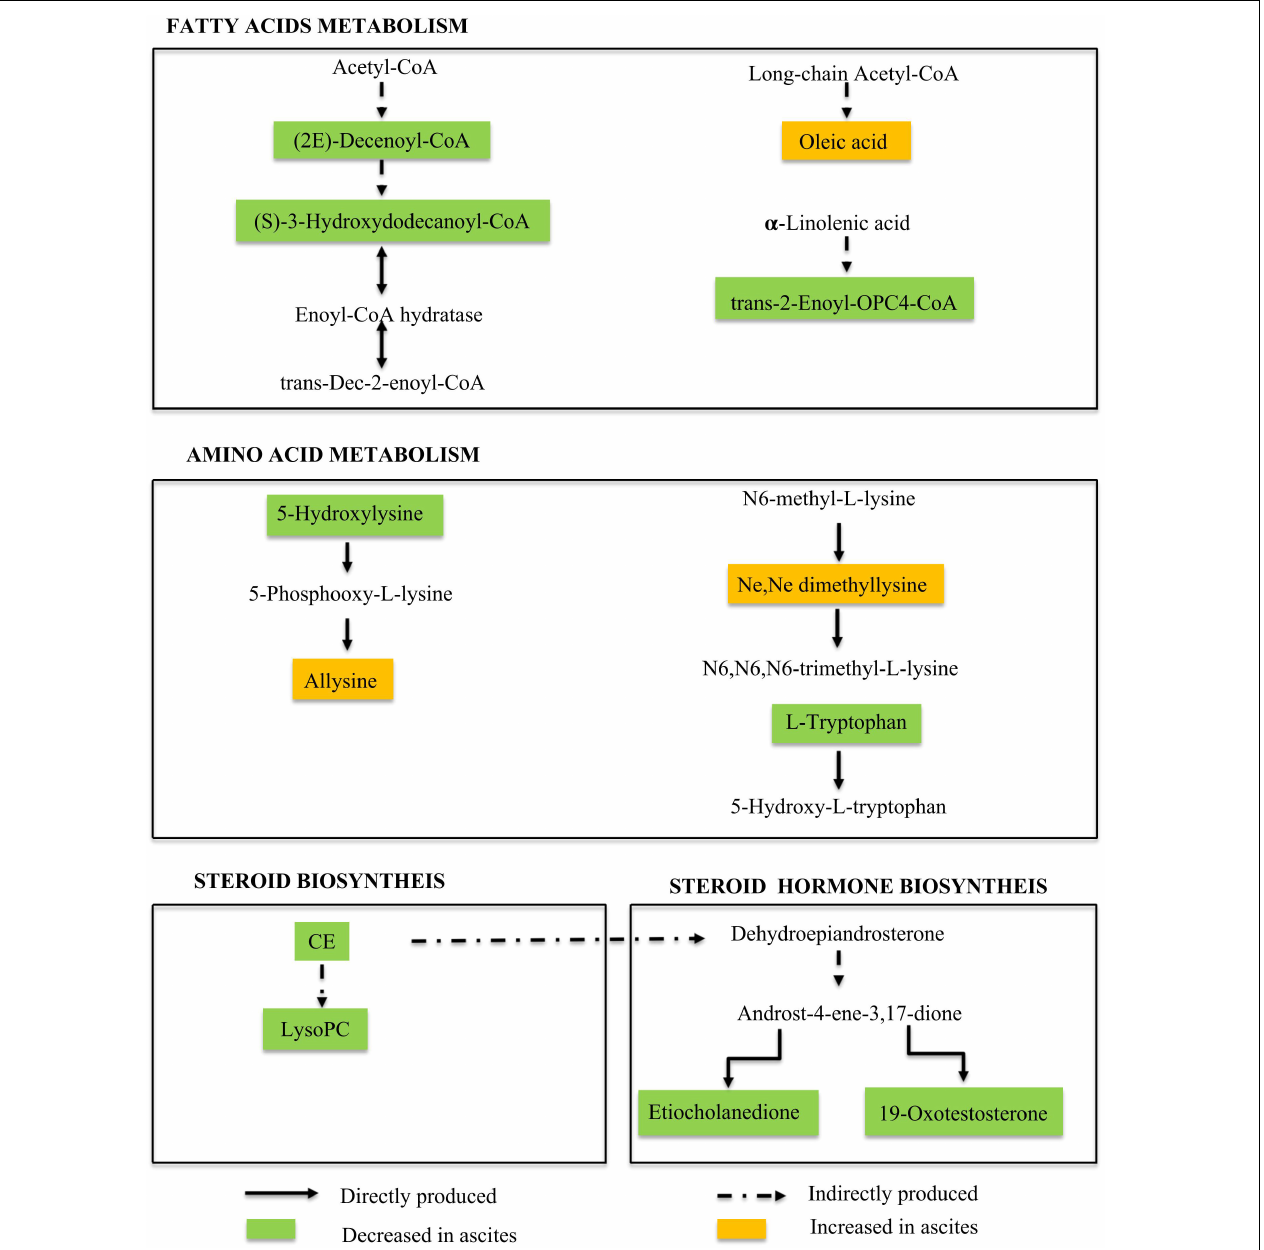
FIGURE 4 | Metabolic pathways involved in ALD patients with ascites. Our data suggested the dysregulation in the fatty acid metabolism pathway, amino acid metabolism pathway, and steroid and hormone biosynthesis pathway during ALD-related ascites